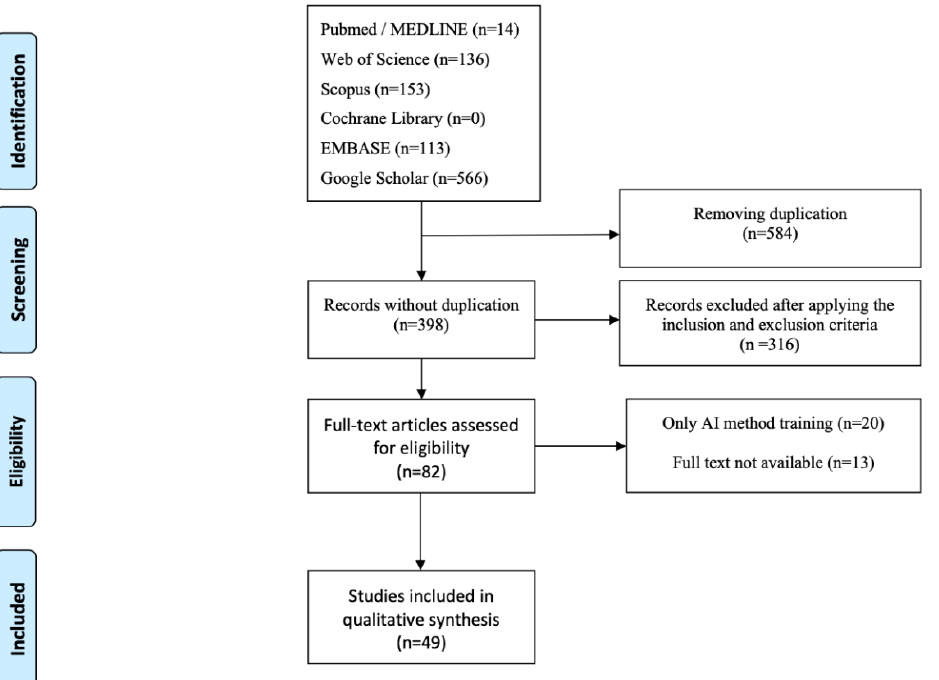
Figure 1. PRISMA systematic-review flow diagram.